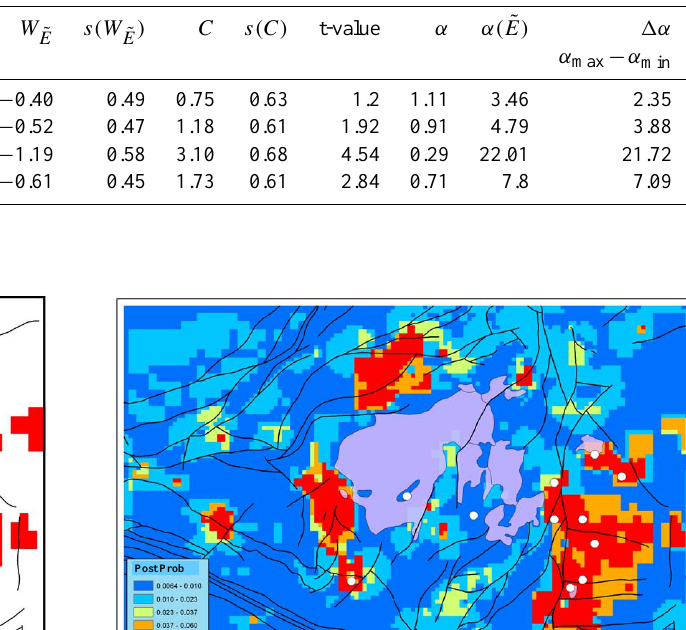
Table 1. Statistics obtained from each of the four layers of binary maps.